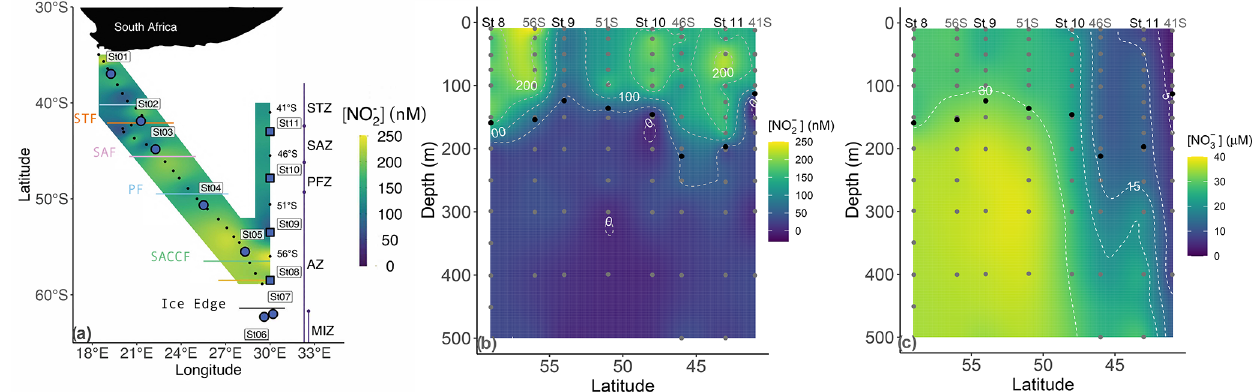
Figure 1. (a) Map of the cruise track showing the kinetics stations (large circle symbols) and locations of the underway stations sampled during Leg 1 (small symbols), overlaid on the measured surface ( ∼ 7m) nitrite concentrations ([NO − hydrocast stations occupied during Leg 2 are shown, with the stations at which depth-profile experiments were conducted indicated by the large square symbols. The colored horizontal lines denote the frontal positions at the time of sampling, and the major zones of the Southern Ocean are indicated by the vertical lines and dots: STZ, subtropical zone; STF, subtropical front; SAZ, subantarctic zone; SAF, subantarctic front; PFZ, polar frontal zone; PF, polar front; AZ, Antarctic zone; SACCF, southern Antarctic circumpolar front; MIZ, marginal ice zone. Also shown are water column (0–500m) profiles of the concentrations of (b) nitrite (NO − The grey dots indicate the discrete sampling depths at all the hydrocast stations (eight in total), with the four stations at which depth-profile experiments were conducted (St 08 to St 11) labeled above the panel. The black dots show the derived mixed-layer